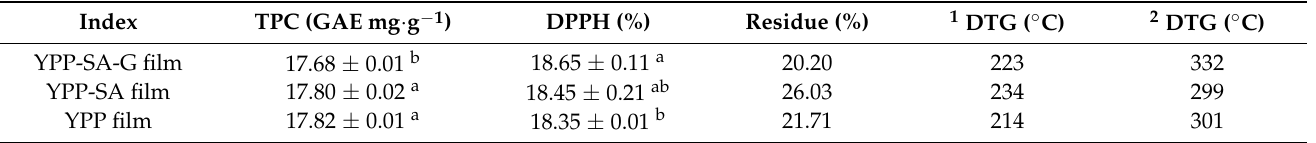
Table 8. Antioxidant capacity and thermal properties of all prepared